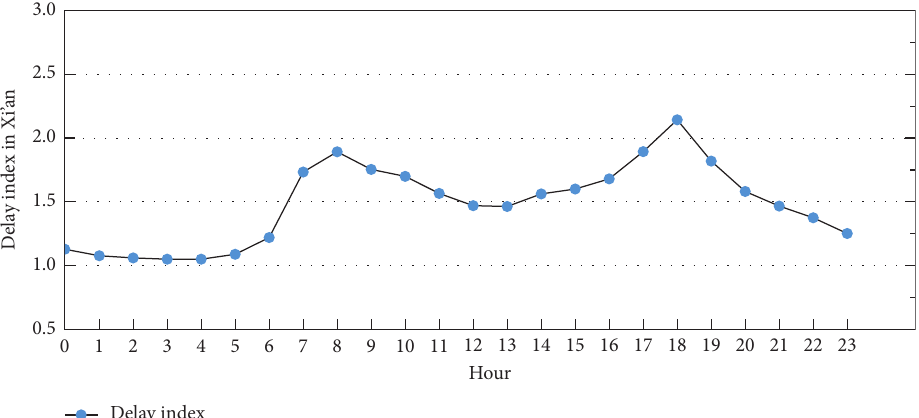
Figure 4: The congestion index in Xi’an on 2020.10.21. The real-time congestion index can be gathered from Autonavi Company web page at https://report.amap.com/detail.do?city � 610100.